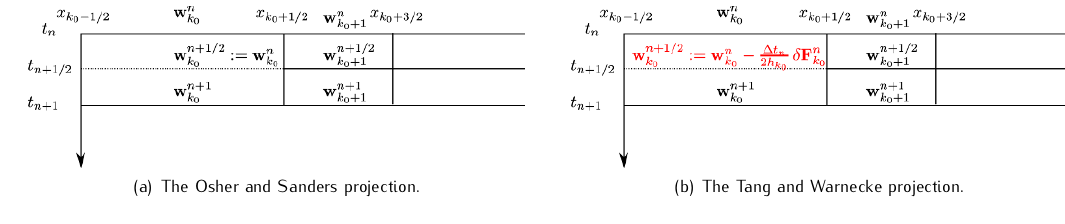
Figure 4. Projection